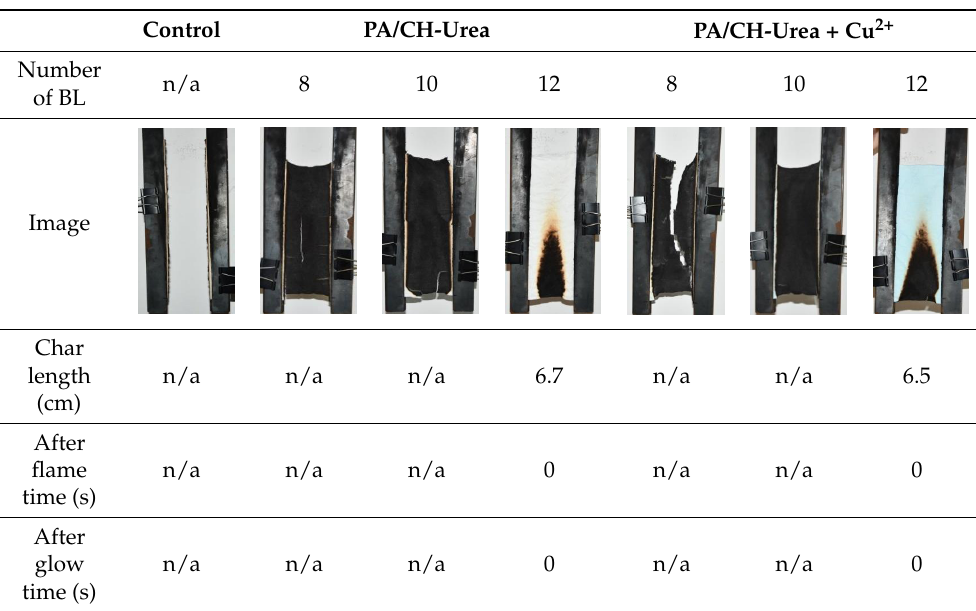
Table 2. The results of the VFT of cotton coated with different recipes. Control